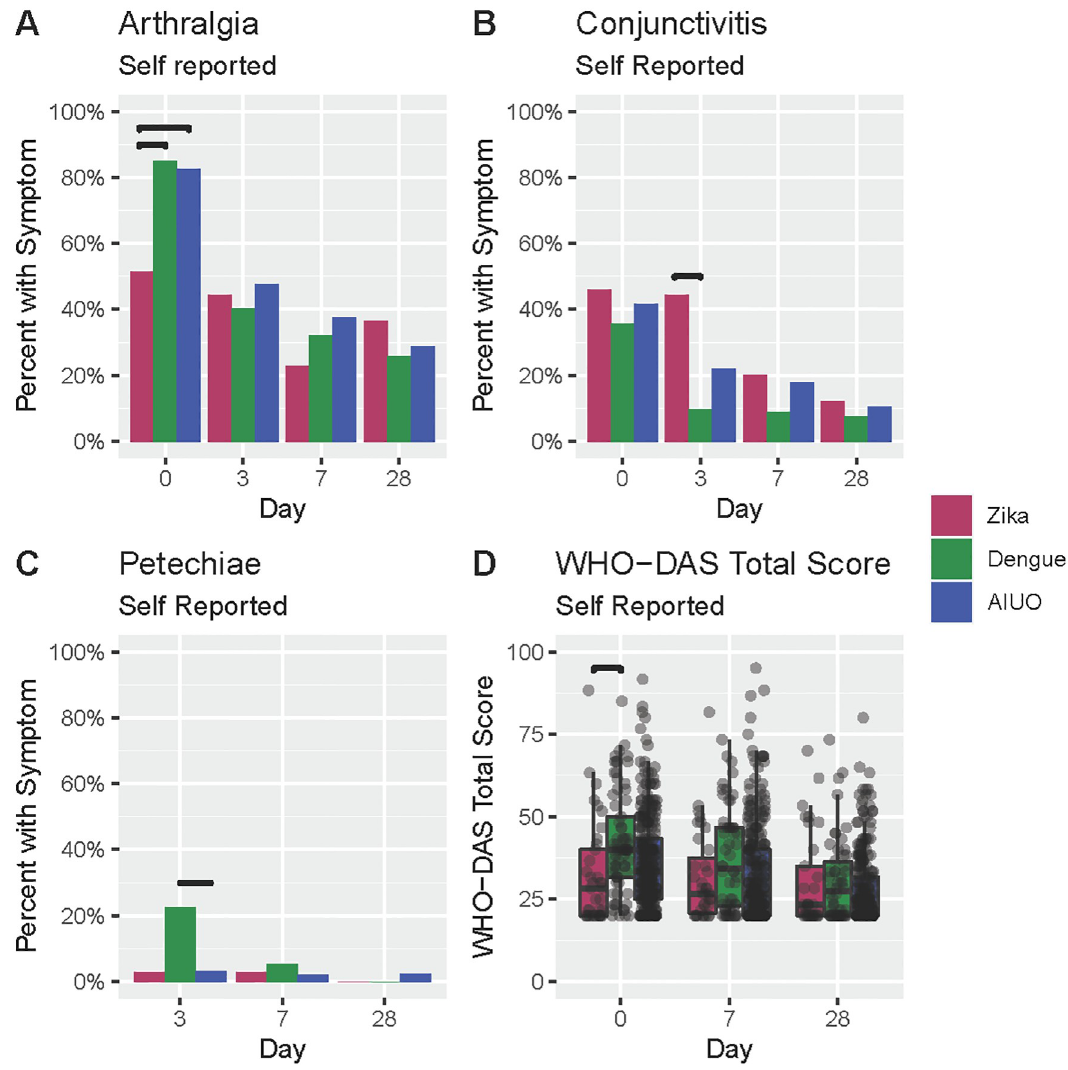
Fig 1. Comparison of self-reported signs and symptoms among patients with confirmed Zika, dengue and AIUO. Darker lines above bars indicate statistically significant comparisons.